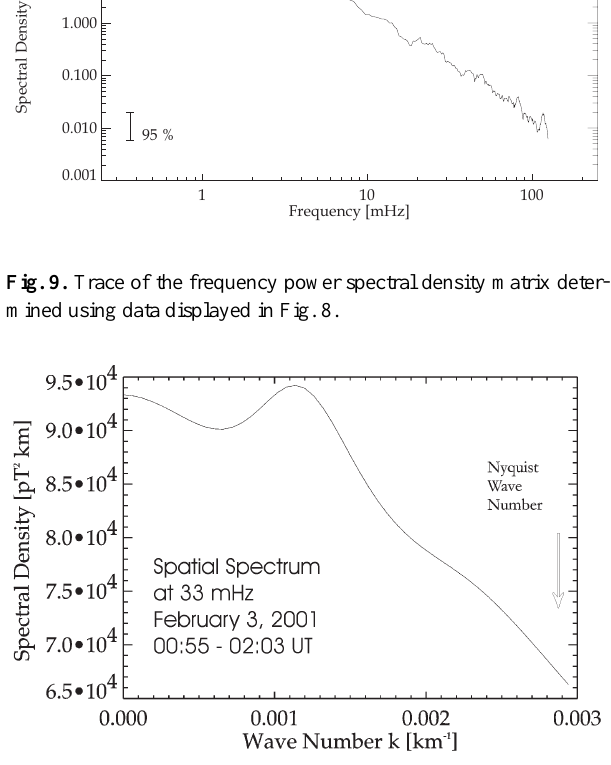
Fig. 10. Spatial spectrum determined using magnetic field data from all four Cluster spacecraft in the interval on 3 February 2001, 00:55–02:03UT. The logarithm of the power is displayed.